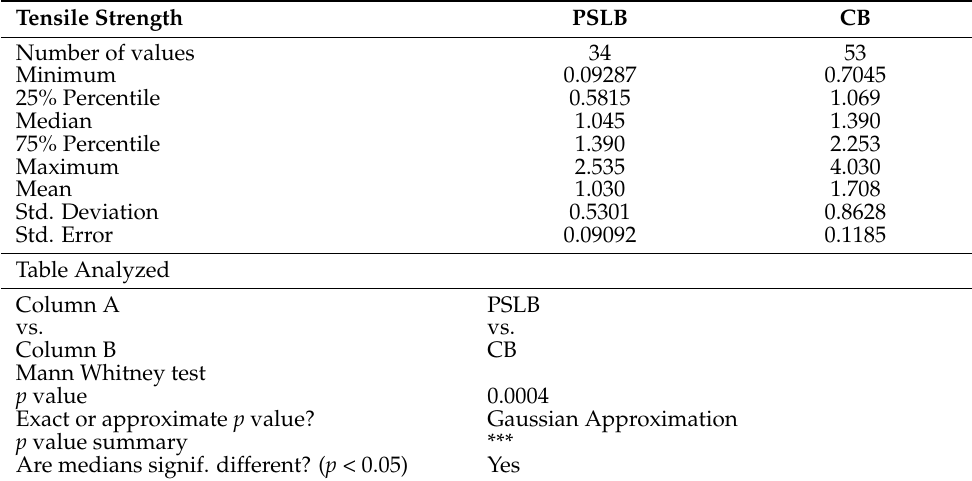
Table A7. Tensile strength: passive self-ligating vs. conventional brackets. Tensile Strength Number of values